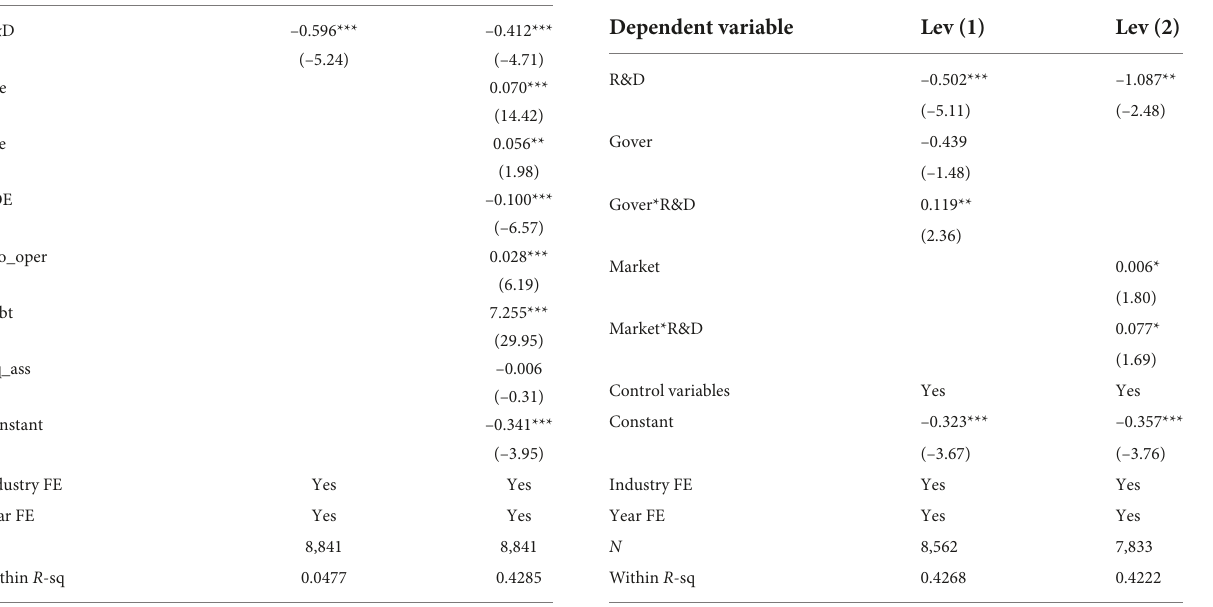
TABLE 4 Impact of technological innovation on corporate leverage. TABLE 5 Impact of policy incentives and market competition on the relationship between technological innovation and corporate